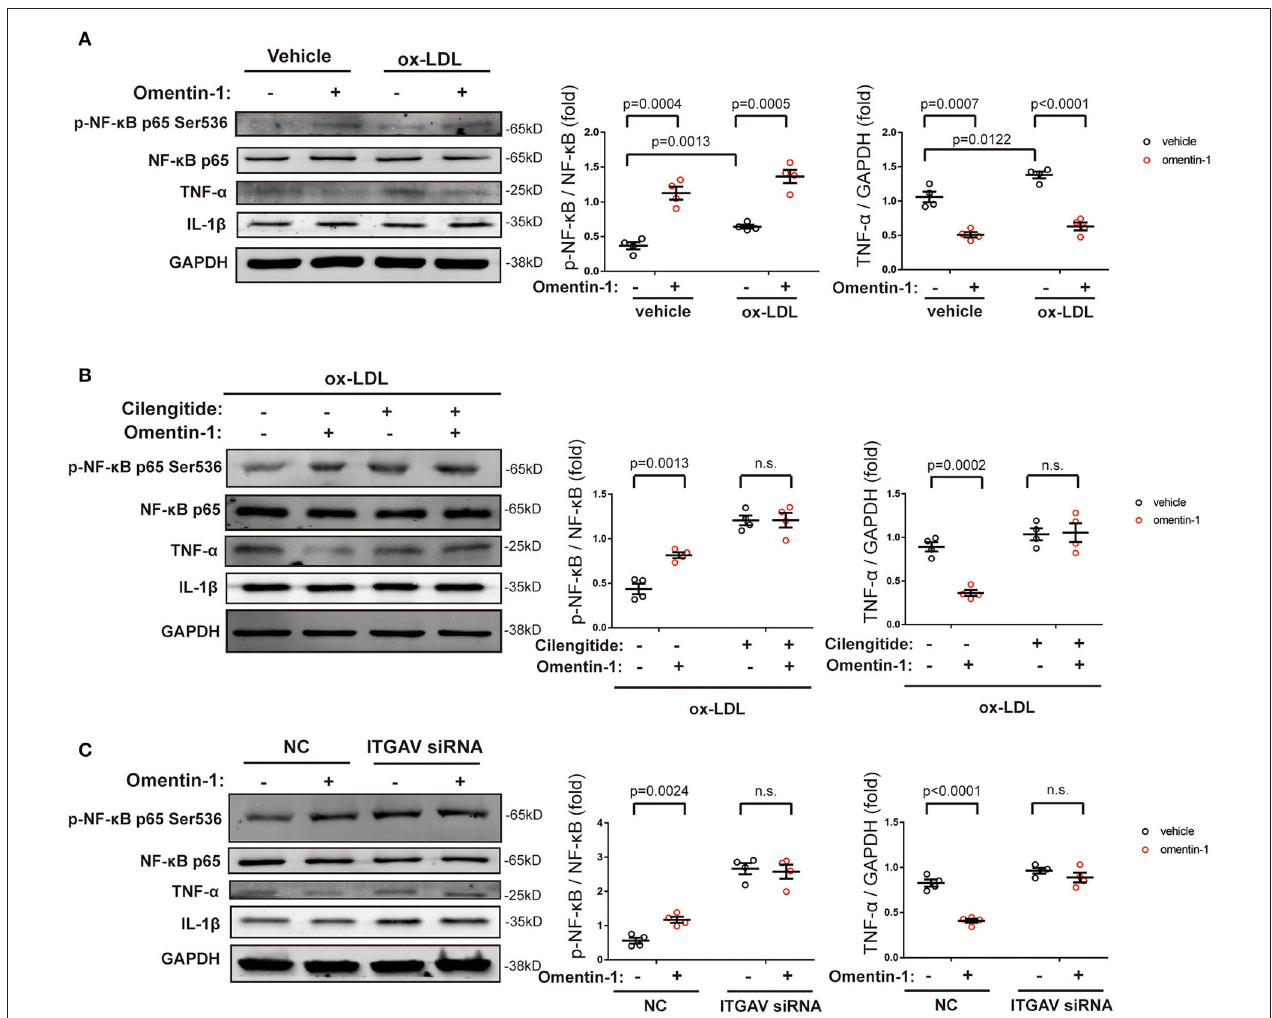
FIGURE 6 | The effects of omentin-1 on inflammatory cytokines expression in the macrophage. (A) The RAW264.7-derived macrophages were pretreated by omentin-1 (700ng/ml) for 1h. After that, the vehicle (sterilized water) and high ox-LDL (50 µ g/ml) were added to the medium and co-incubated with cells for 6h. The cells were harvested for immunoblotting analysis. The greyscale of each blot was quantified and normalized ( n = 4). (B) The RAW264.7-derived macrophages were pretreated by cilengitide (2.5 µ M) for 1h and co-incubated with or without omentin-1 (700ng/ml) for another 1h. After that, they were all stimulated by high ox-LDL (50 µ g/ml) for 6h. The cells were harvested for immunoblotting analysis. The greyscale of each blot was quantified and normalized ( n = 4). (C) The RAW264.7-derived macrophages were transfected by ITGAV siRNA for 6h. Then the medium was replaced by RPMI 1640 [containing 5% fasting blood sugar (FBS)] and the cells were incubated for 15h. After that, omentin-1 (700ng/ml) was added to the medium and co-incubated with cells for 1h. All of the cells were then treated by high ox-LDL for 6h. The cells were harvested and subjected to immunoblotting analysis. The greyscale of each blot was quantified and normalized ( n = 4). All data in this figure were presented as mean ± SEM (n.s.,